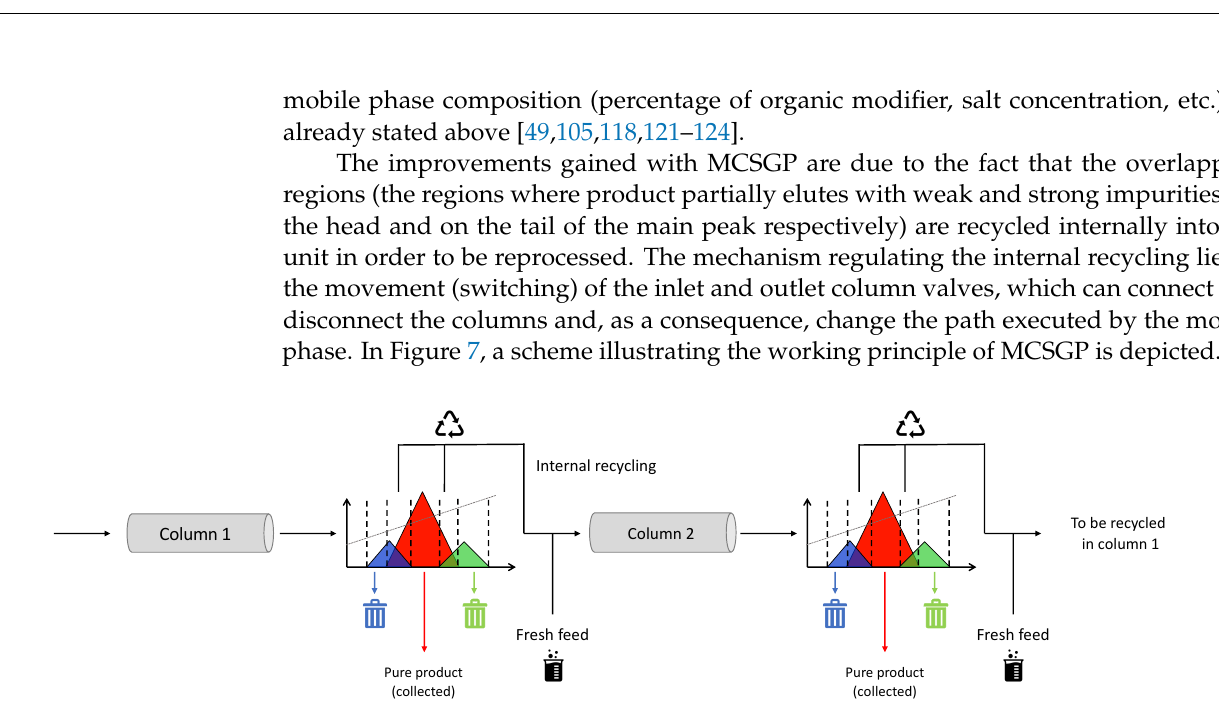
Figure 7. A scheme illustrating the MCSGP technique is shown. The gradient elution is performed in the first column. The main peak (red) overlaps in the front and in the tail with other groups of impurities (blue and green). The overlapping regions are therefore internally recycled into the second columns in order not to waste product, whereas the central part of the red peak (pure target product) is collected. On the contrary, windows where only impurities elute with no product are discarded. The same procedure is repeated at the outlet of the second column, where the overlapping regions are recycled into the first one. During the recycling, also some fresh feed is loaded into the same column, in order to keep the total amount of product constant into the